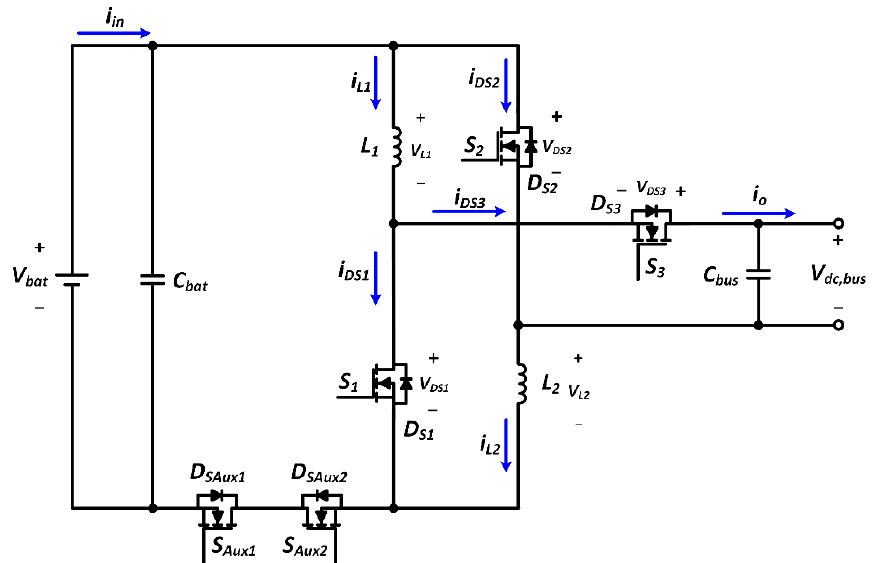
Figure 2. The topology of the proposed bidirectional DC-DC converter.